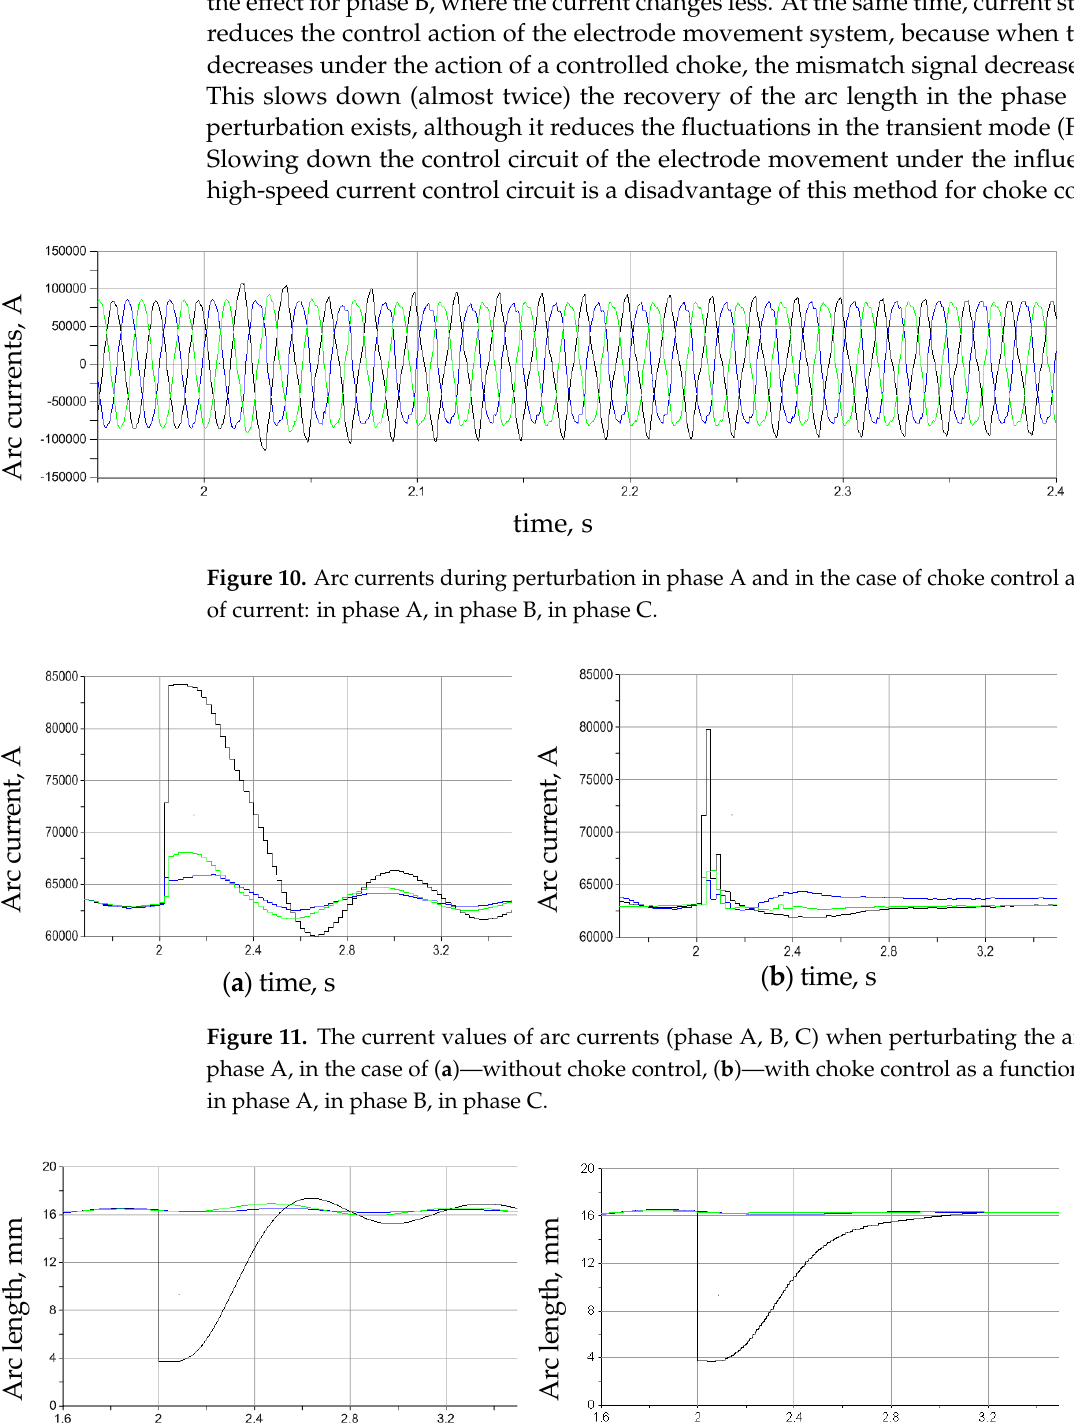
Figure 11. The current values of arc currents (phase A, B, C) when perturbating the arc length in phase A, in the case of ( a )—without choke control, ( b )—with choke control as a function of current: in phase A, in phase B, in phase C.